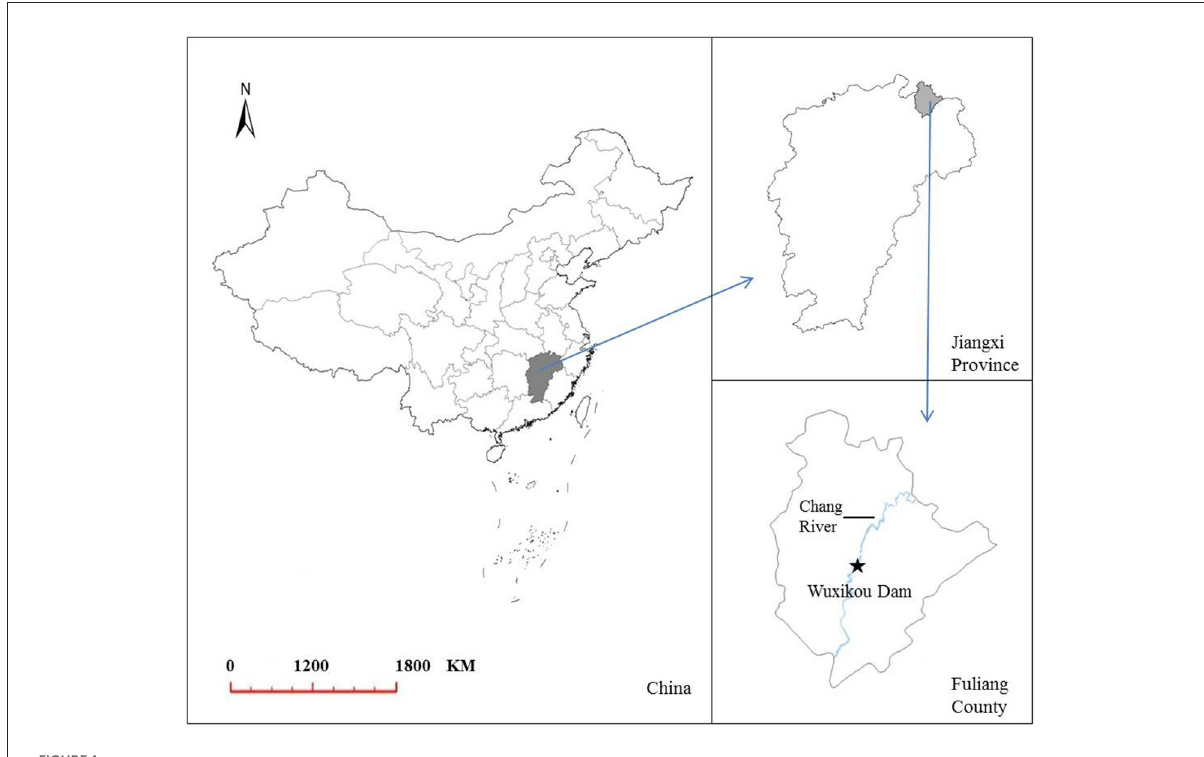
FIGURE1 Case study